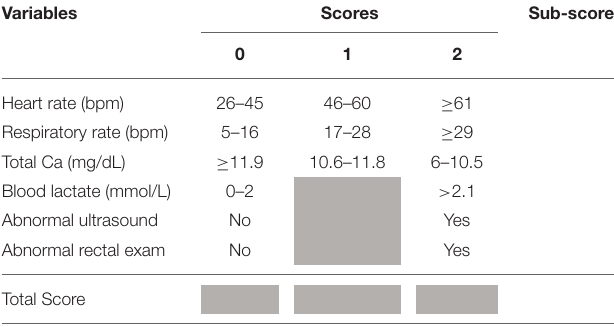
TABLE 2 | Colic assessment score.